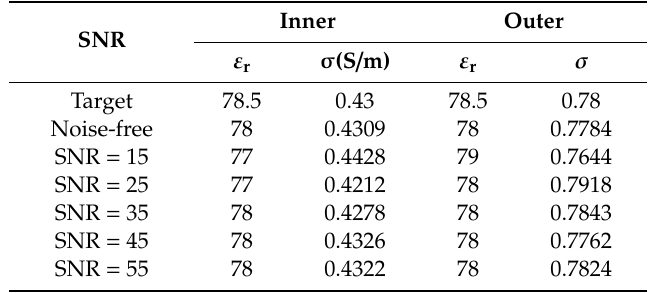
Table 1. Reconstructed EPs of the phantom (based on simulated data).